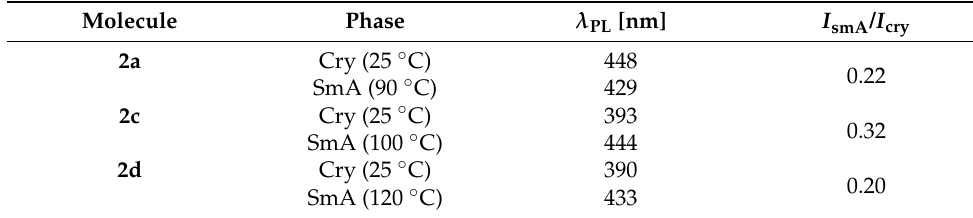
Figure 6. PL spectra of ( a ) 2a , ( b ) 2c , and ( c ) 2d in Cry and SmA phases. Excitation wavelength: 380 nm for 2a , 362 nm for 2c , and 392 nm for 2d . Table 3. PL behavior difference between Cry and SmA phases in 2a , 2c , and 2d .